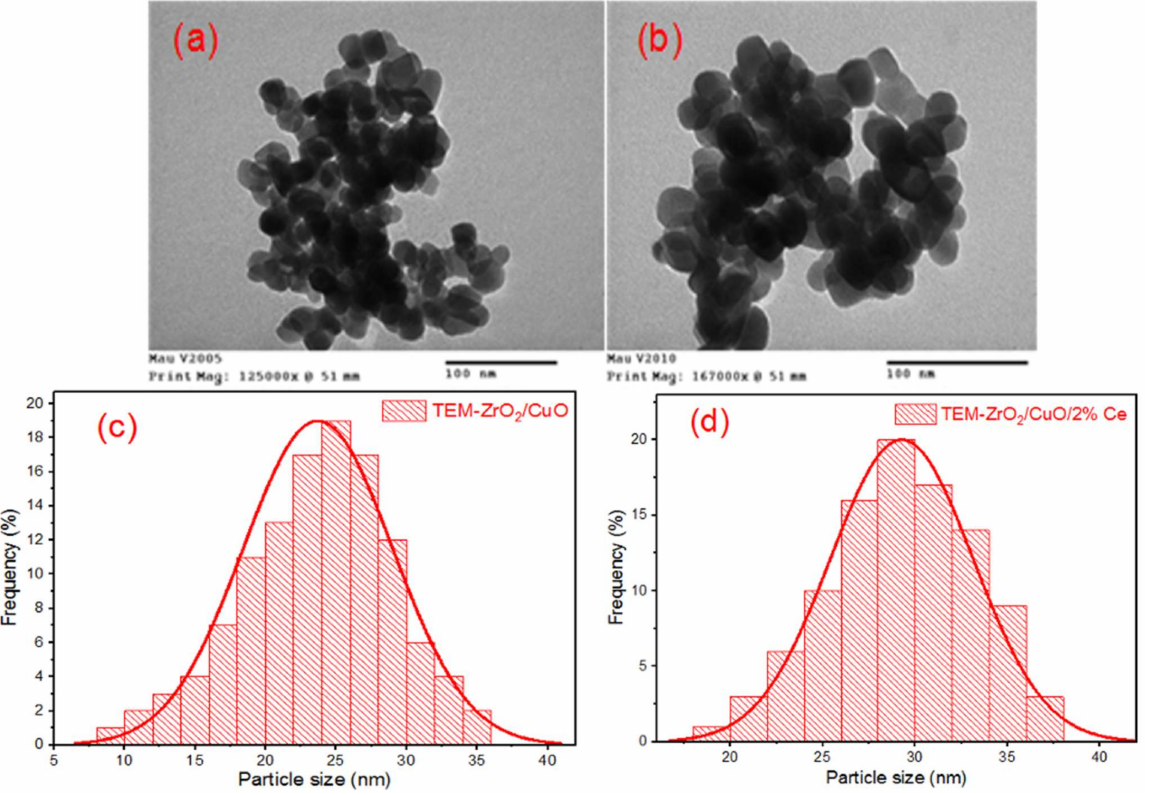
Figure 3. TEM and the particle size distribution curve of ZrO 2 /CuO ( a , c ) and 2 mol% Ce 3+ /Ce 4+ - doped ZrO 2 /CuO ( b , d